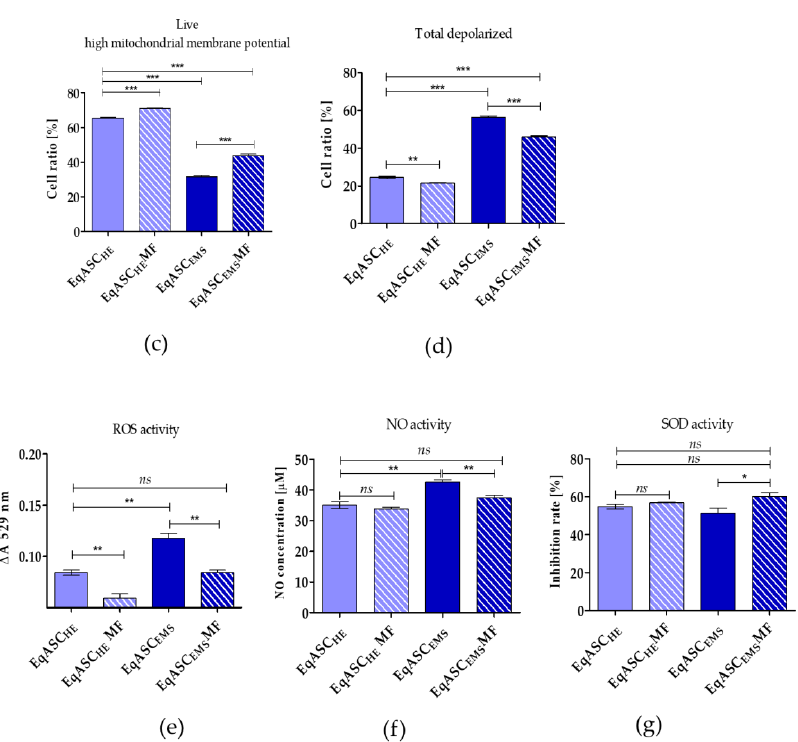
Figure 3. The influence of metformin on mitochondrial membrane potential and oxidative. Representative dot plots indicating distribution of cells accordingly to the mitochondrial membrane potential ( a ). The ultrastructure of EqASC HE and EqASC EMS without metformin treatment and after metformin treatment. Mitochondria are indicated with red arrows, and nuclei with nu symbol, scale bar: 2 μ m ( b ). Analysis of cell viability based on mitochondrial potential ( c ). Comparison of total depolarised cells in tested experiments ( d ). Evaluation of reactive oxygen species ( e ), nitric oxide ( f ) and superoxide dismutase activity ( g ). Significant changes are indicated with asterisks: * p < 0.05; ** p < 0.01 and *** p < 0.001, while non-significant differences are marked as ns